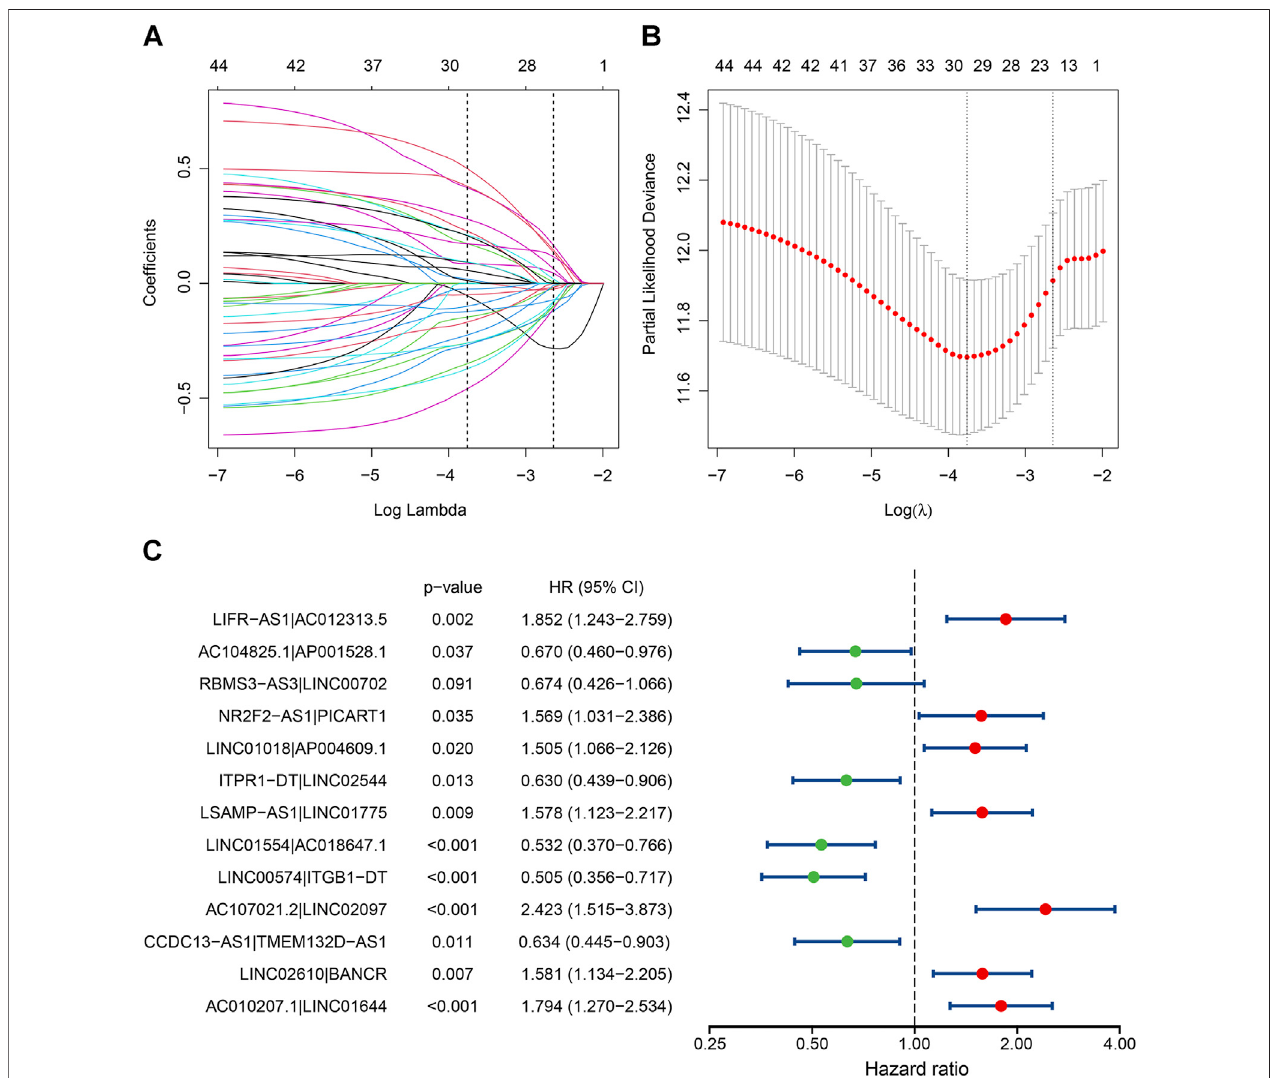
FIGURE1| Identi fi cationoftheprognosticsignatureintheTCGAcohort. (A) Theleastabsoluteshrinkageandselectionoperator(LASSO)coef fi cientpro fi lesofthe prognostic immune-related lncRNA pairs (IRLPs); (B) The 10-fold cross-validated partial likelihood deviance. The lambda value was con fi rmed as 0.07124 at one standard deviation of the minimal deviance, which resulted in 20 non-zero coef fi cients; (C) The forest map showed 13 IRLPs identi fi ed by multivariate Cox proportional hazard regression in the stepwise method.